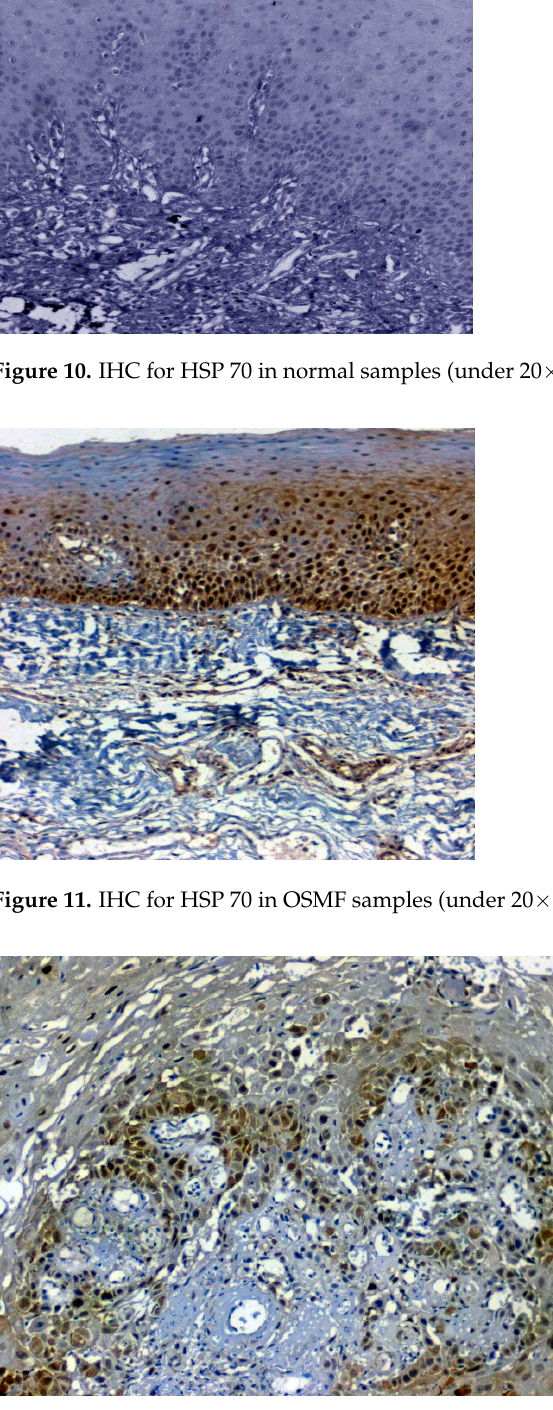
Figure 12. IHC for HSP 70 in OSCC samples (under 20× magnification).